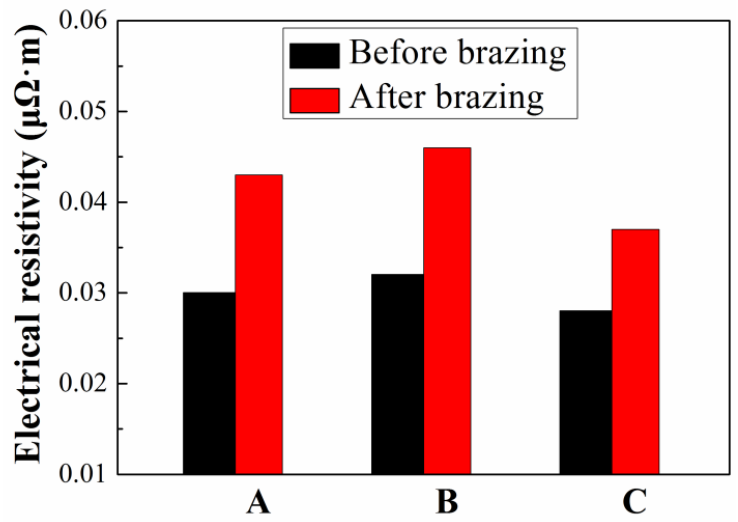
Figure 11. Electrical resistivity evolution of experimental alloys during brazing. A, B, C in the figure represent sample A, sample B and sample C.